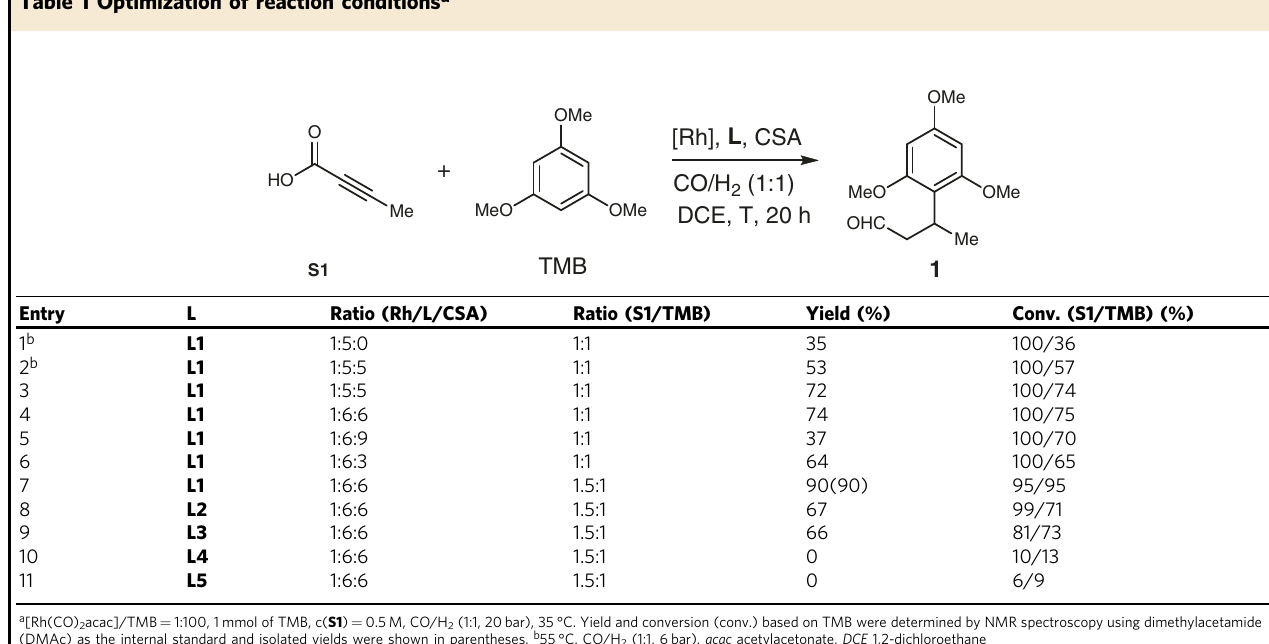
Table 1 Optimization of reaction conditions